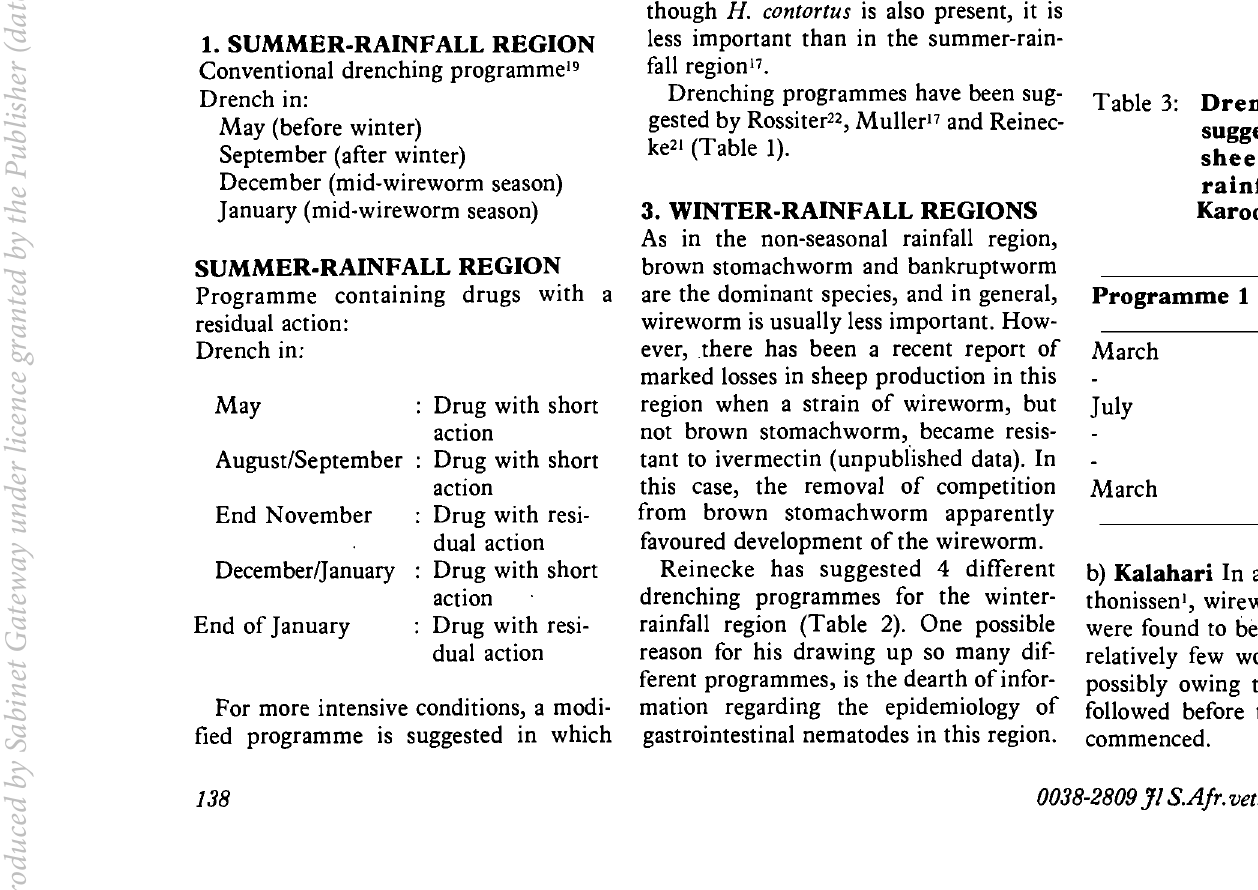
Table 3: Drenching programmes suggested by Viljoen27 28